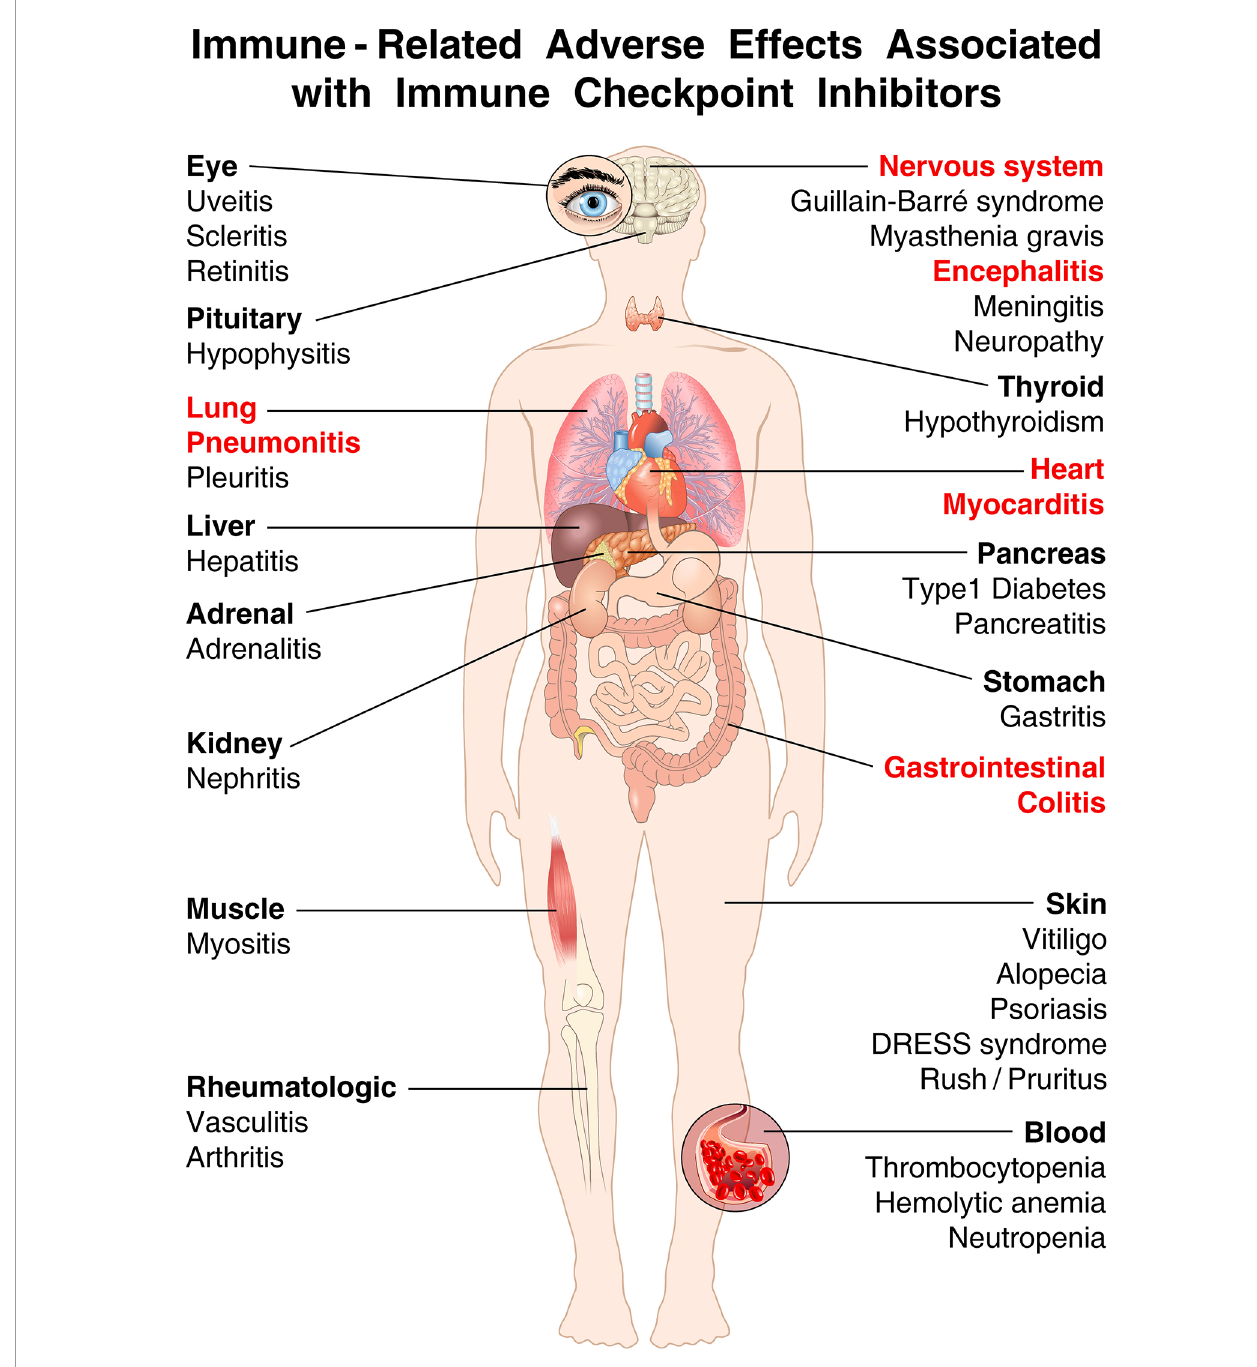
FIGURE 3 | The spectrum of organs affected by irAEs associated with immune checkpoint inhibitors (ICIs) is very broad. Shown are the most common immune- related adverse events (irAEs) that clinicians can encounter in cancer patients treated with ICIs. irAEs contributing to most fatalities are highlighted in red [modi fi ed from (19)]. ICI-associated diabetes is almost exclusively seen in patients treated with anti-PD-1/PD-L1 antibodies, and rarely with ipilimumab monotherapy (42, 118). By contrast, hypophysitis occurs more often in patients receiving ipilimumab (119). Colitis occurs more commonly with ipilimumab and with combined immune checkpoint blockade than with anti-PD-1/PD-L1 alone (112, 120). Endocrinopathies (such as hypothyroidism, hypophysitis, and adrenal insuf fi ciency) and rheumatological disorders have the highest incidence of development into subacute/chronic toxicity (49). Endocrine toxicities, unlike many other irAEs, are not managed using high- dose glucocorticoids, which have no effect on either initial severity and resolution (121, 122). Although acute myocarditis was the fi rst cardiovascular irAEs associated with ICIs (123), an important unanswered question relates to the long-term cardiovascular sequelae of ICIs (49, 56,